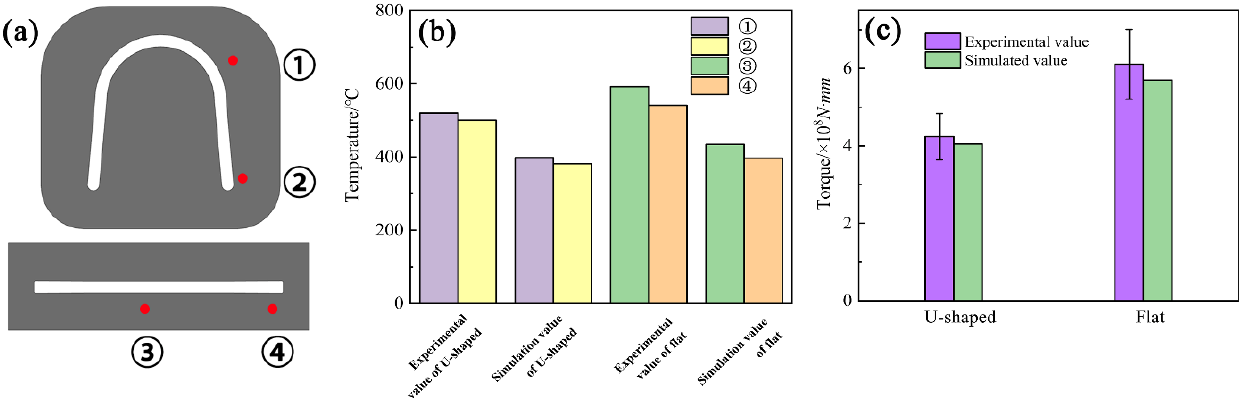
Figure 9. Experimental value and simulated value: ( a ) The temperature measuring points at the exit of the die; ( b ) Temperature; ( c ) Torque of the extrusion wheel.